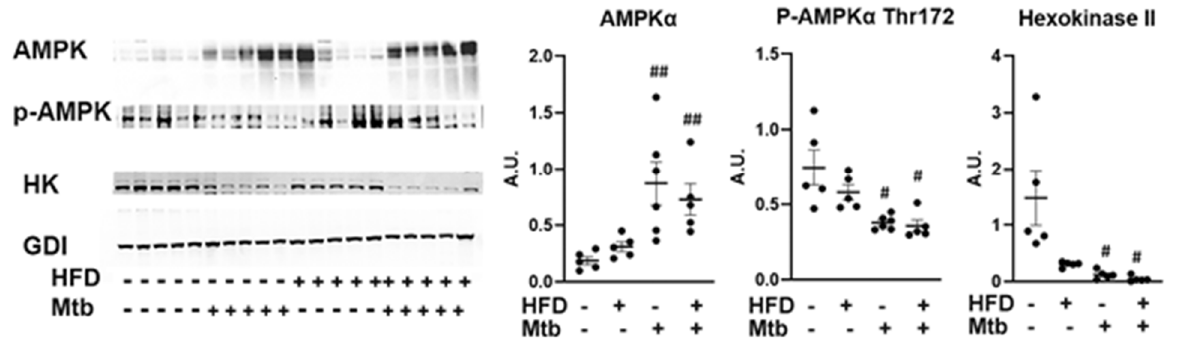
Figure 8. Changes in AMPK signaling in the lungs of Mtb infected adult mice. Immunoblot analysis of AMPK pathway proteins (AMPK α , p-AMPK α ) and glycolytic enzyme (Hexokinase II) in the lung lysates of infected and uninfected adult mice. GDI was used as loading control. Fold changes in the protein levels were normalized to GDI expression and are represented as a dot plot. The error bars represent standard error of the mean. # p < 0.05, ## p < 0.01, compared to uninfected RD mice ( n = 5/group).